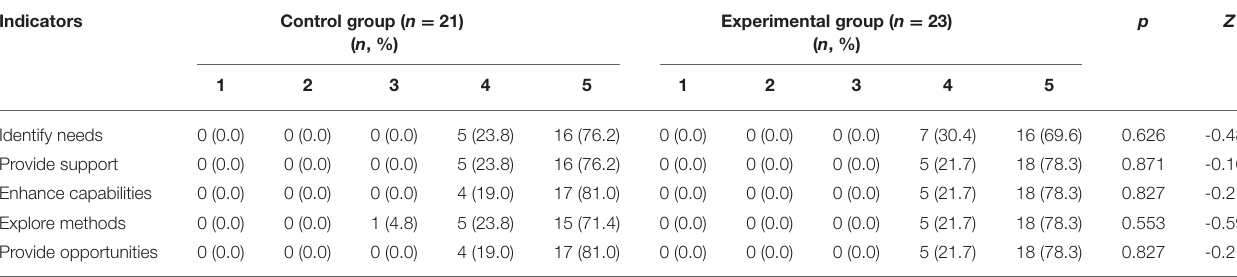
TABLE 4B | Evaluation of the teacher’s performance (simulation running). Indicators Control group ( n = 21) ( n , %)